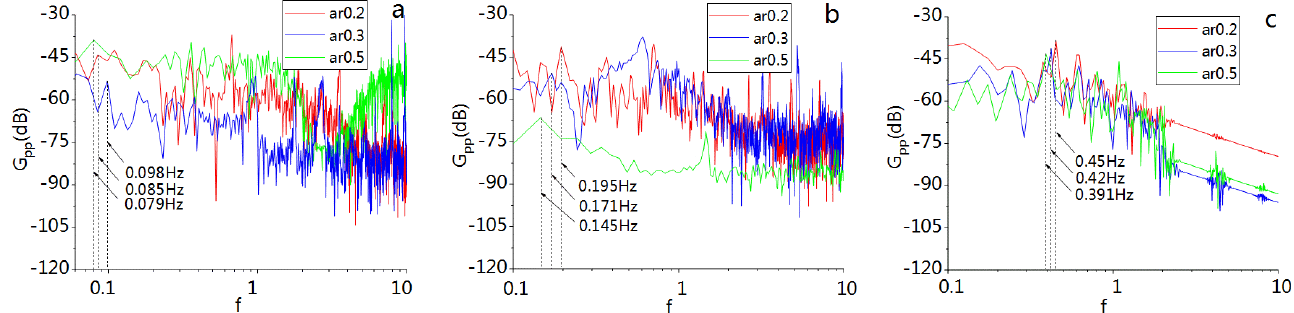
Figure 14. Power spectrum of fluctuating pressure signals: ( a ) Re = 1000; ( b ) Re = 2000; ( c ) Re = 5000